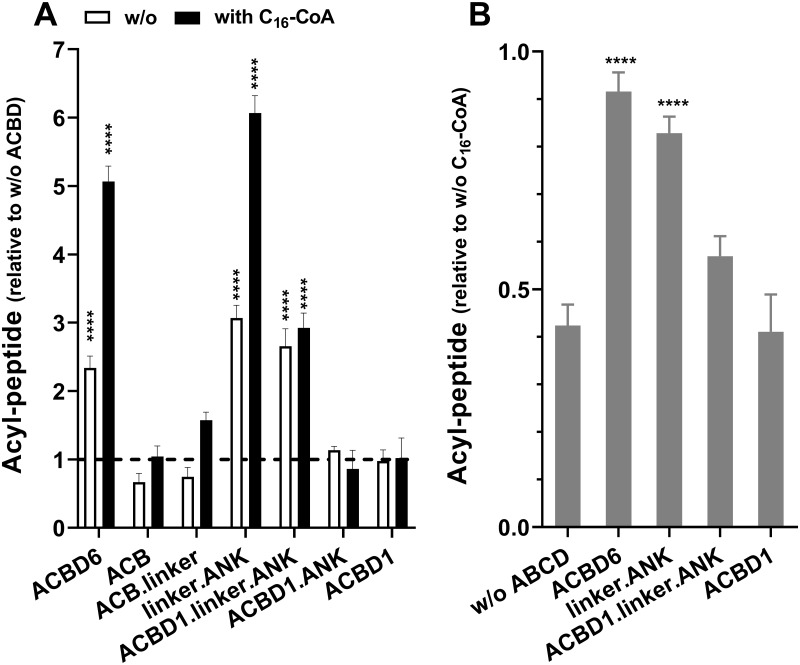
The C-terminal module is sufficient for NMT2 stimulation and protection.Formation of the myristoyl-peptide by NMT2 was measured in the presence of the indicated proteins over a concentration range of 0.016 to 4μM for 3 min at 37°C. The full data set is presented in S1 Fig. The bar graphs summarize the values obtained at 4μM. Human NMT2 enzyme was added at a concentration of 50nM in the presence of 5μM C14-CoA and in the absence (white bars) or presence of excess competitor C16-CoA (50μM) (filled bars). Control reactions were performed in the absence of the ACBD constructs and of C16-CoA. The data are presented relative to the value obtained in the absence of ACBD (panel A) or in the absence of C16-CoA (panel B). Error bars represent the standard deviations of values obtained from three reactions. **** indicate a p value of <0.0001.